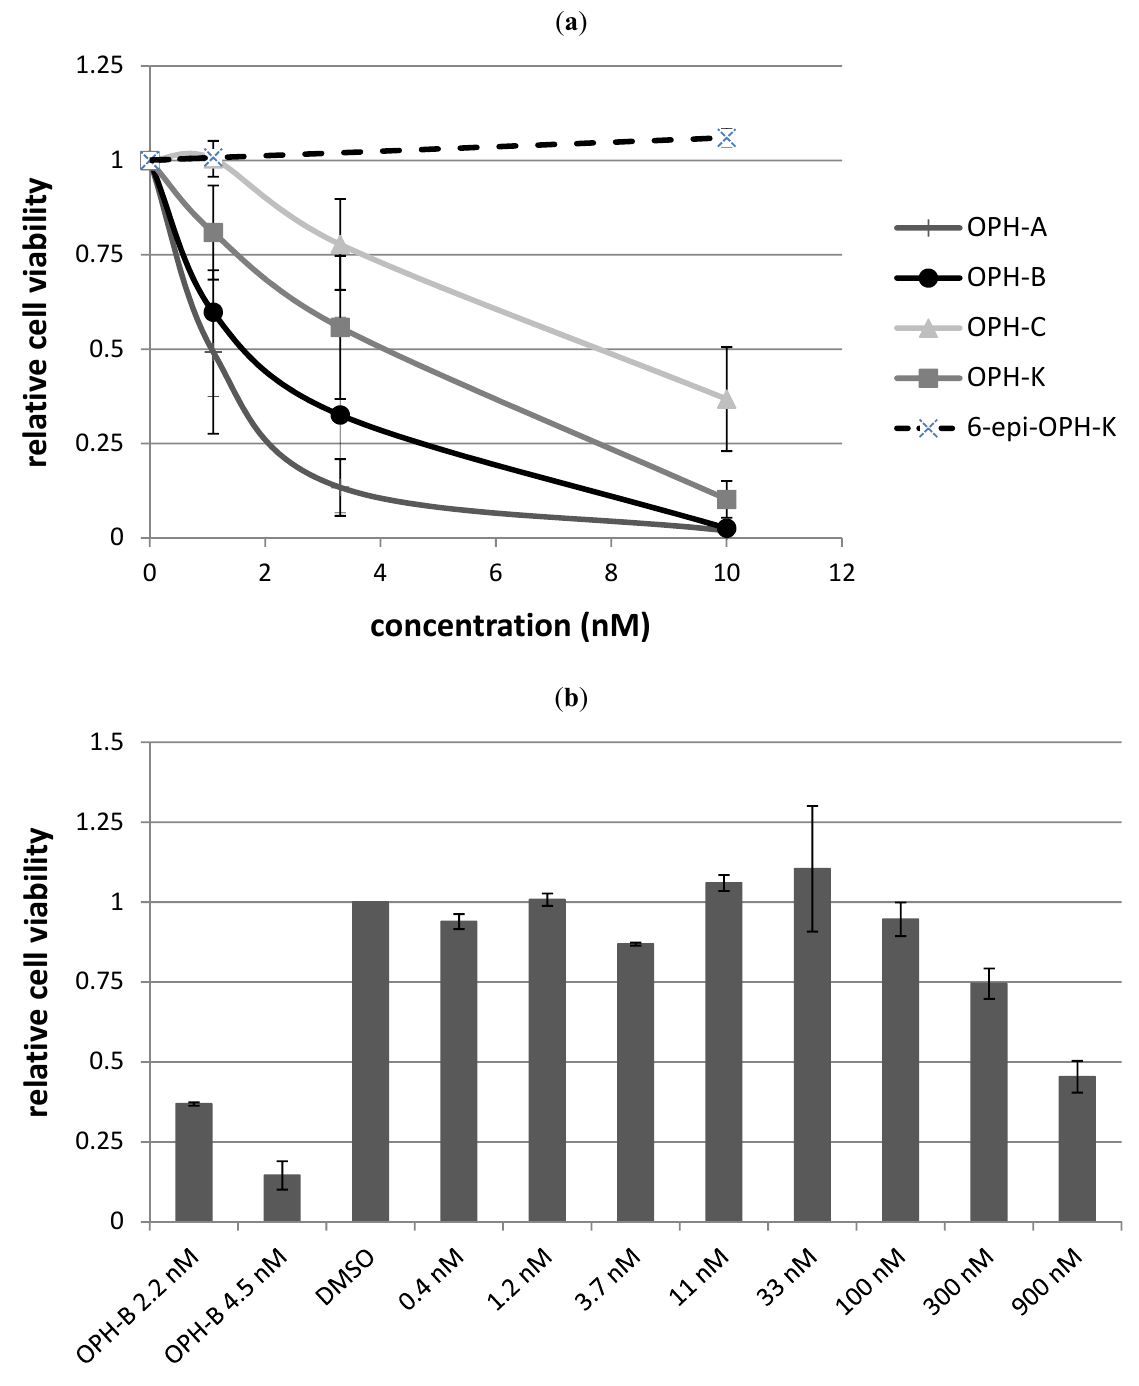
Figure 12. Effects of different ophiobolins on CLL cell viability. ( a ) CLL cells cultured in HS-5 conditioned media were treated for 24 h with increasing concentrations of ophiobolin A, ophiobolin B, ophiobolin C, ophiobolin K, and 6-epiophiobolin K, and cell viability was analyzed by CellTiter-Glo ® assay measuring each data point as duplicate. Relative cell viability compared to DMSO control (0.1%) is depicted as mean values +SD of 3 independent CLL samples; ( b ) As 6-epiophiobolin K treatment did not decrease cell viability in the concentration range tested in (a), CLL cells were treated with up to 900 nM of 6-epiophiobolin K, and cell viability was determined and compared to the active ophiobolin